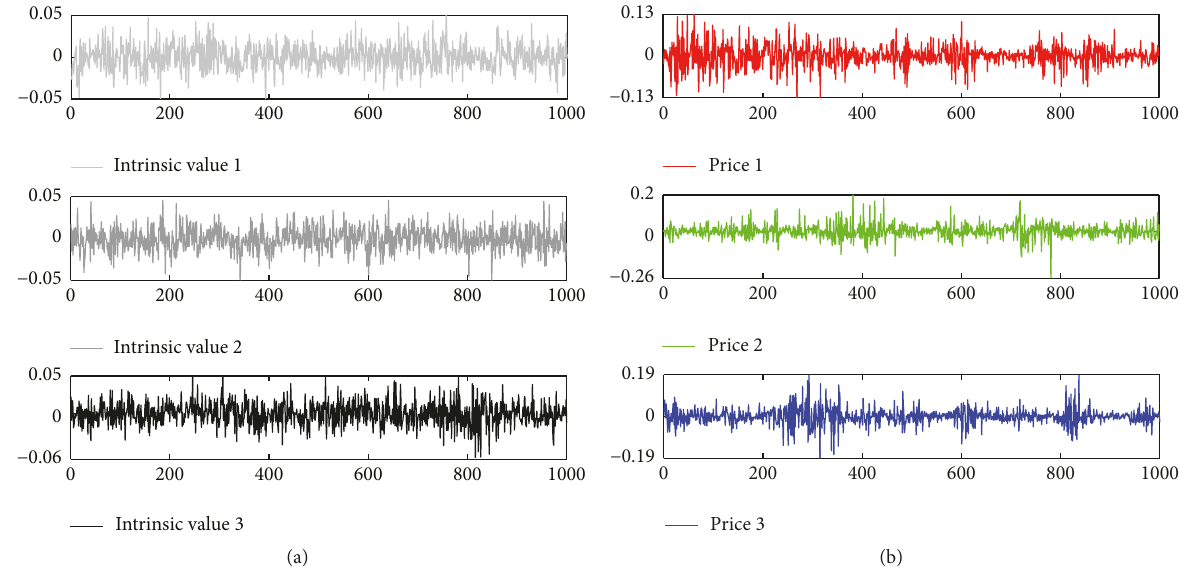
Figure 2: Time series of returns of intrinsic values and